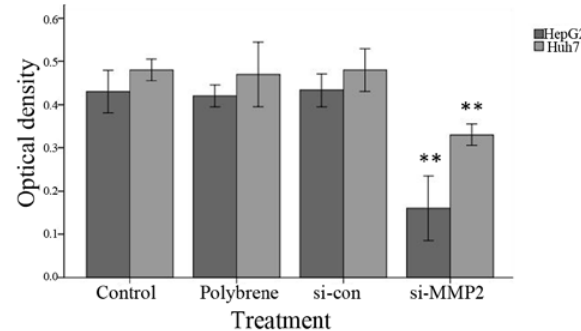
Figure 4 . Effects of MMP2 knockdown on the sensitivity HepG2 (at 48 h after transduction) and Huh7 cells (at 72 h after transduction) to cisplatin using MTT assays. ** P<0.01 vs. the normal control group, according to one-factor analysis of variance (ANOVA) follo- wed by a post hoc least significant difference (LSD) test.